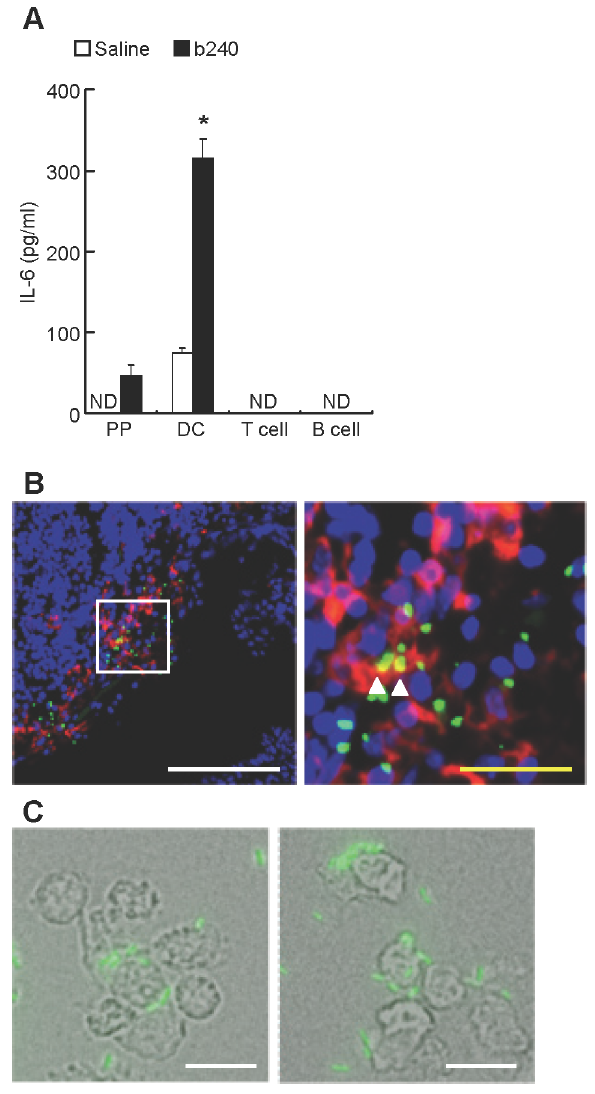
Figure 4. IL-6 producing cells in the PPs in response to b240. (A) Purified CD11c + B220 2 cells as DCs, CD4 + cells as T cells, CD19 + cells as B cells from the PPs, or PP cells (1 6 10 5 cells) were cultured with (black) or without (white) heat-killed b240 (1.6 6 10 6 counts) for 3 days. IL-6 in the culture supernatants was determined by CBA. Data are expressed as mean 6 SEM (n=3). ND, not detected. The detection limit was 20 pg/ ml. * P , 0.05 by Student’s t -test. Data are representative of 2 independent experiments producing similar results. (B) After the ligated intestinal loop assay with 1 mg/ml of FITC-labeled b240, histological analysis was performed to examine the co-localization of b240 (green) with DCs in PP. Tissue sections were prepared and stained with anti- CD11c antibody (red) and 4,6-diamidino-2-phenylindole (blue). Magni- fication of the area in the first image (white square) shows the contact between b240 and CD11c + cells (arrowhead). White and yellow bars indicate 100 and 25 m m, respectively. (C) After PP CD11c + B220 2 DCs were cultured with FITC-labeled b240 on a Cell Desk, the interaction between PP CD11c + B220 2 DCs and b240 was analyzed using a fluorescence microscope. The bar indicates 10 m